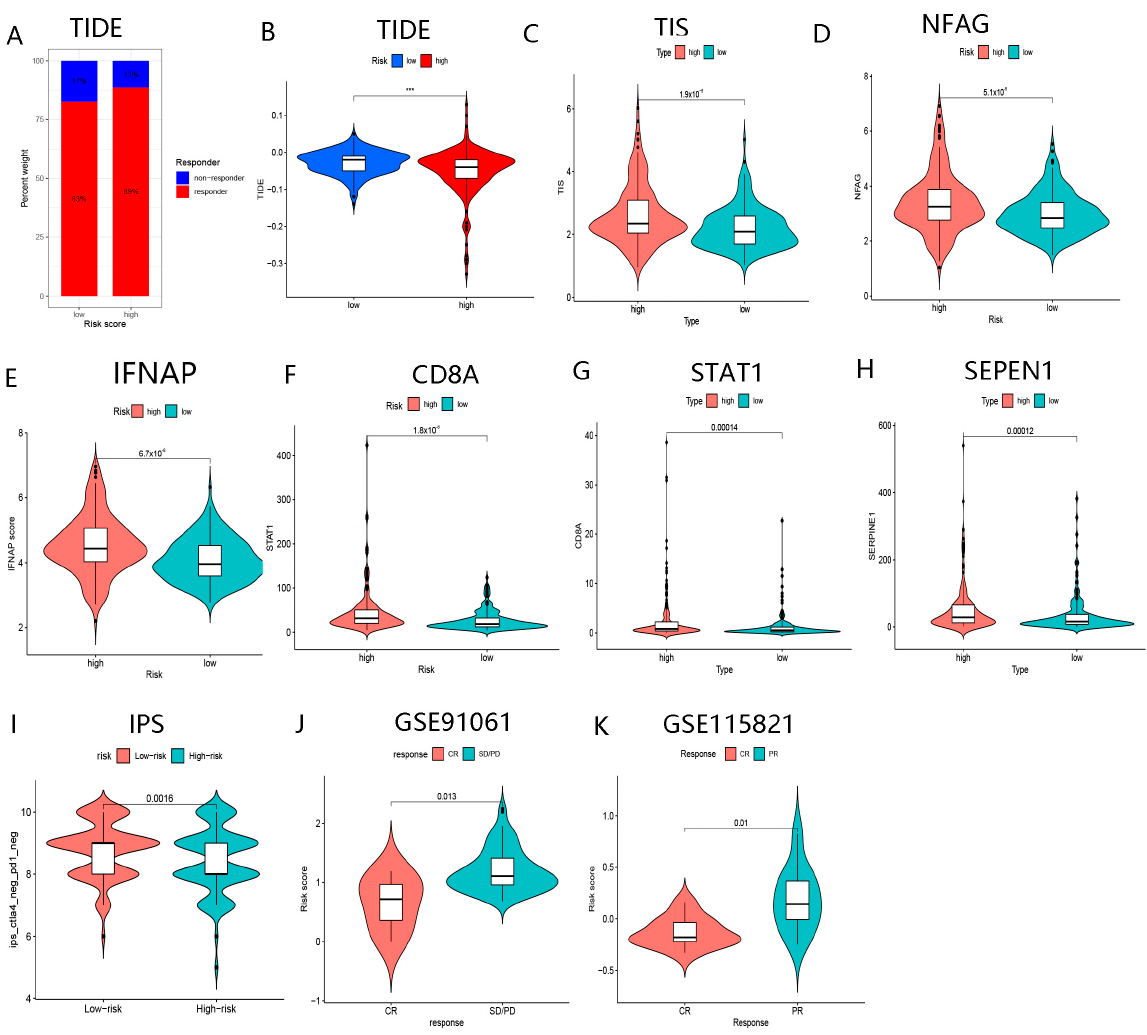
Figure 14. The role of BMGs for the prediction of responses to immunotherapy. ( A ) The ratio of responders and non-responders to immunotherapy in the high- and low-risk groups, respectively. ( B ) Comparison of TIDE scores in low- and high-risk groups. ( C ) Comparison of TIS scores in low- and high-risk groups. ( D ) Comparison of NFAG in low- and high-risk groups. ( E ) Comparison of IFNAP scores in low- and high-risk groups. ( F ) Comparison of the expression level of CD8A in low- and high-risk groups. ( G ) Comparison of the expression level of STAT1 in low- and high-risk groups. ( H ) Comparison of the expression level of SEPEN1 in low- and high-risk groups. ( I ) Comparison of IPS scores in low- and high-risk groups. ( J ) Comparison of risk scores in CR and SD/PD after receiving immunotherapy in the GSE91061 cohort. ( K ) Comparison of risk scores in CR and SD/PD after receiving immunotherapy in GSE115821 cohort. (“***”, represent p <